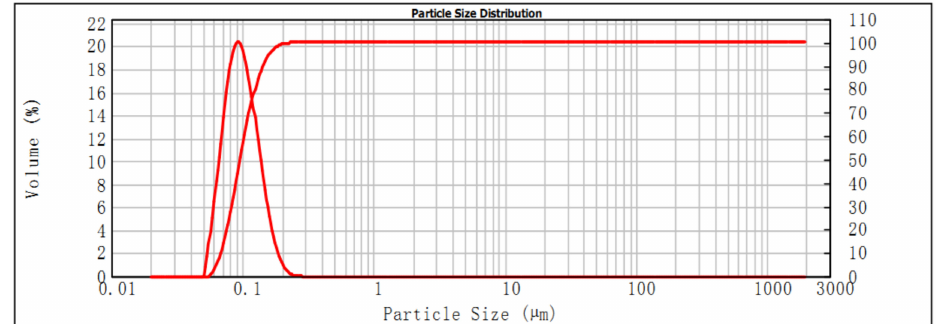
Figure 1. The representative DLS of latex.